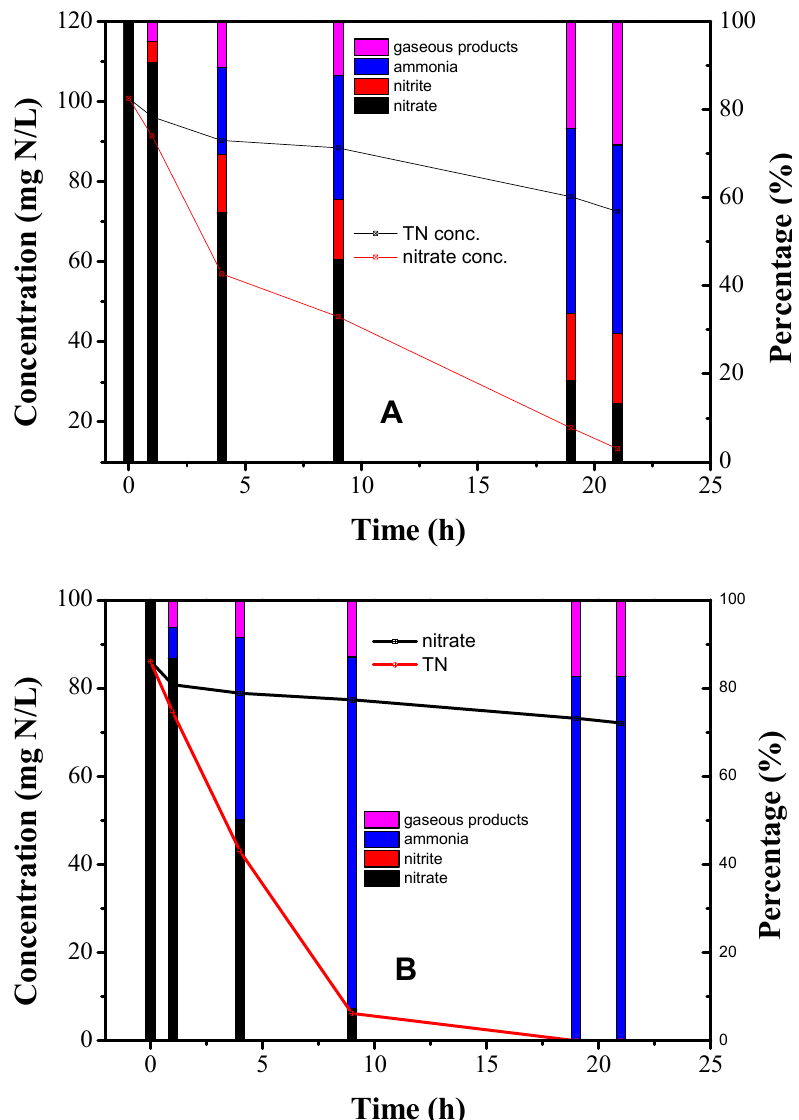
Figure 7. The transformation of nitrogen during constant potential electrolysis at: ( A ) − 0.54 V; ( B ) − 0.74 V.